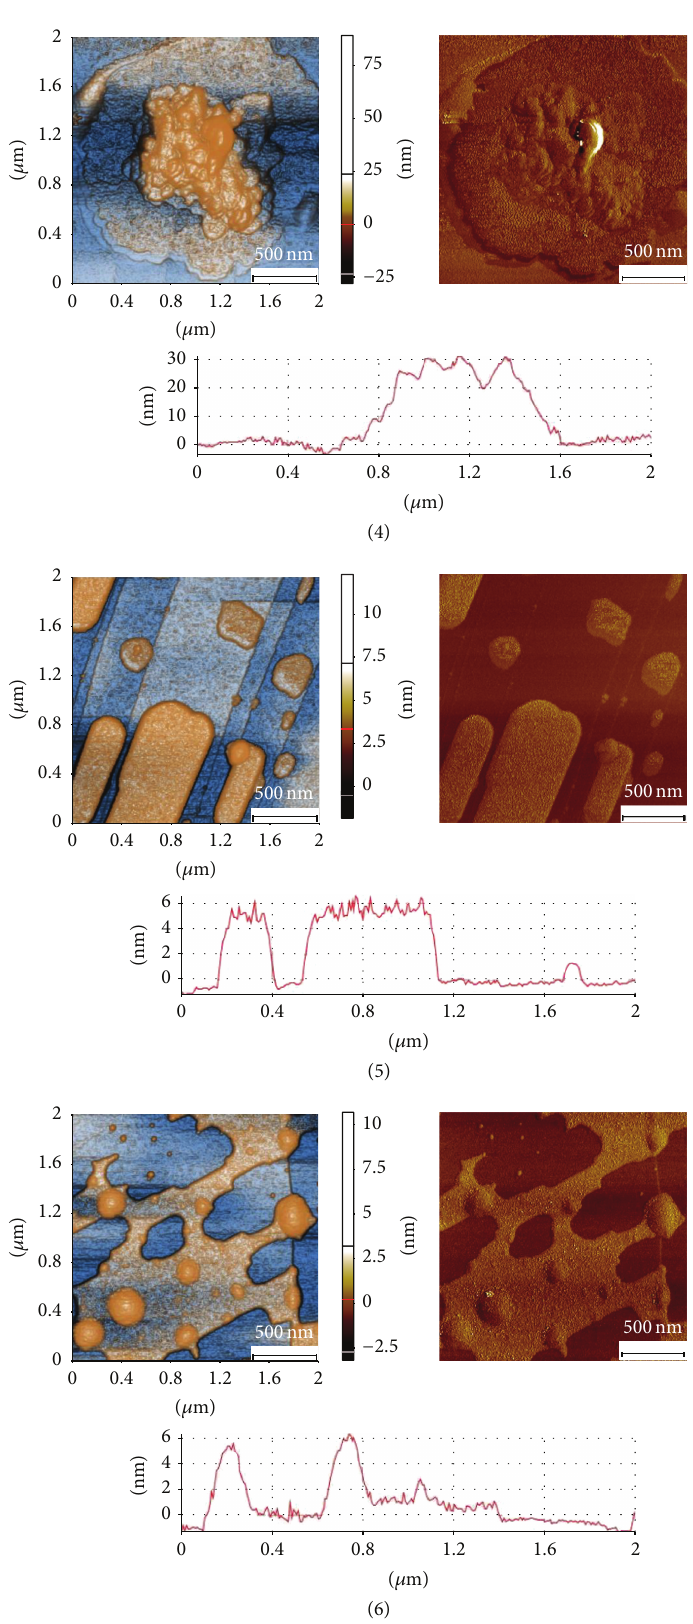
Figure 3: Typical AFM recorded images at the scale of ( 2 × 2 ) 𝜇 m 2 for the investigated porphyrins in which the first column represents the 2D topographic images presented in Enhanced Color view mode and the second column the images recorded in Phase Contrast mode, and below them are the characteristic surface profiles (line scans): (1) TMHAPP; (2) THAPP; (3) MHTPP; (4) TMDOPP; (5) TMDPP; and (6)